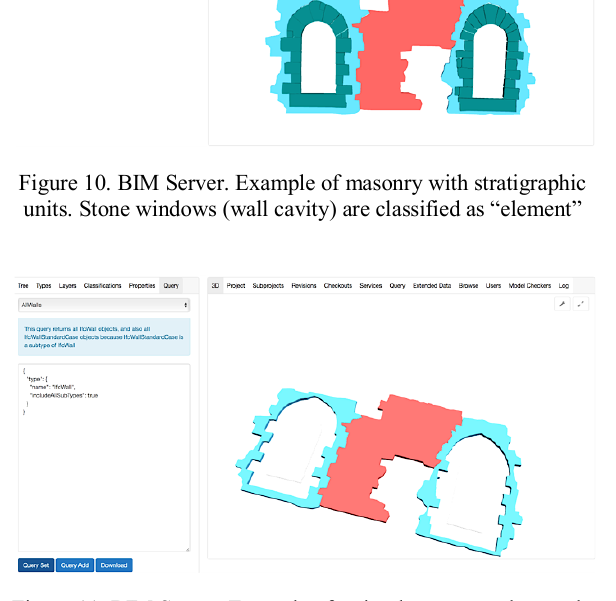
Figure 11. BIM Server. Example of a simple query to show only wall (ifcwall) elements of the